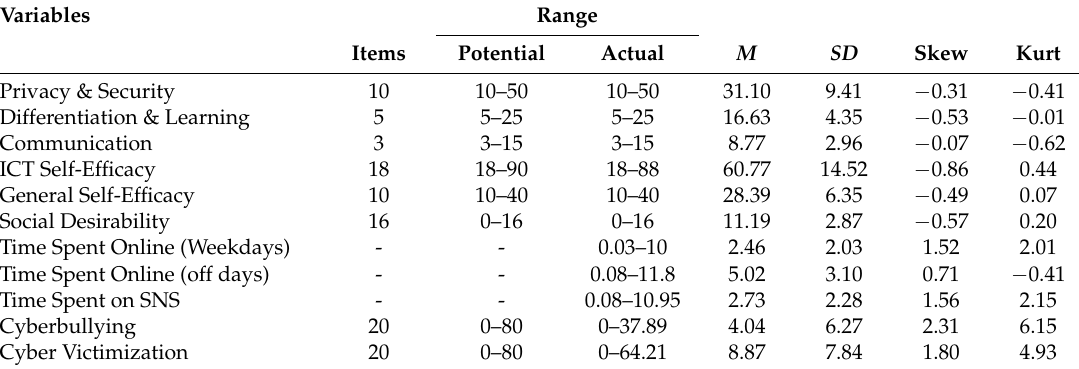
Table 3. Descriptive statistics of the study